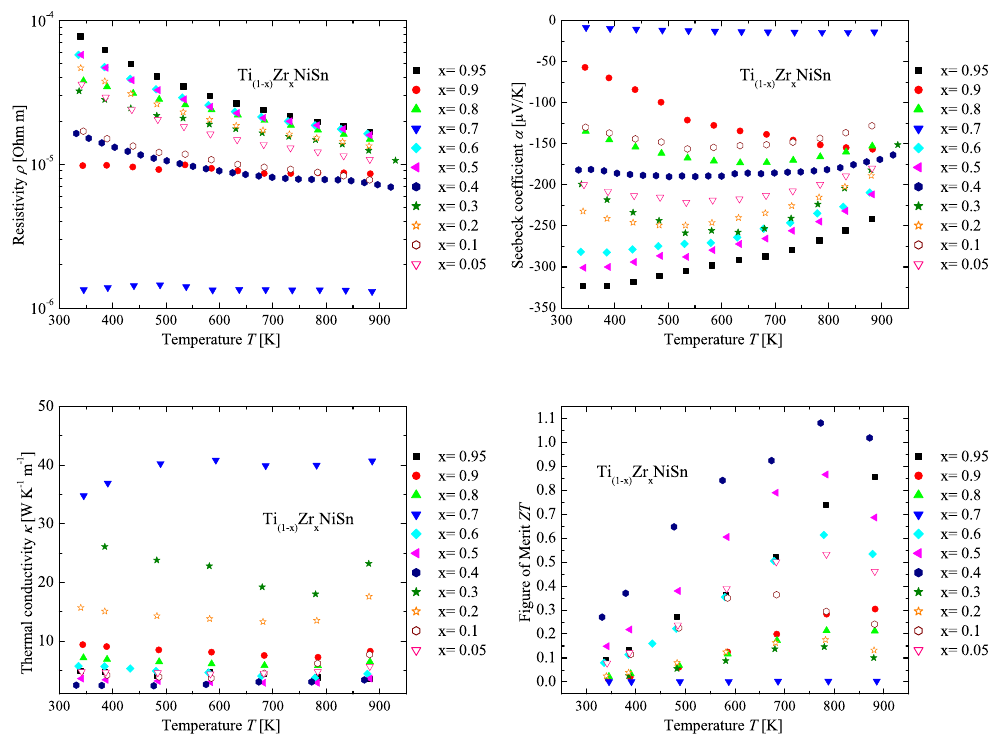
Figure 5. Electrical resistivity ( top left ), Seebeck coefficient ( top right ), thermal conductivity ( bottom left ) and figure of merit ( bottom right ) of the Ti ( 1 − x ) Zr x NiSn series in comparison to the parent